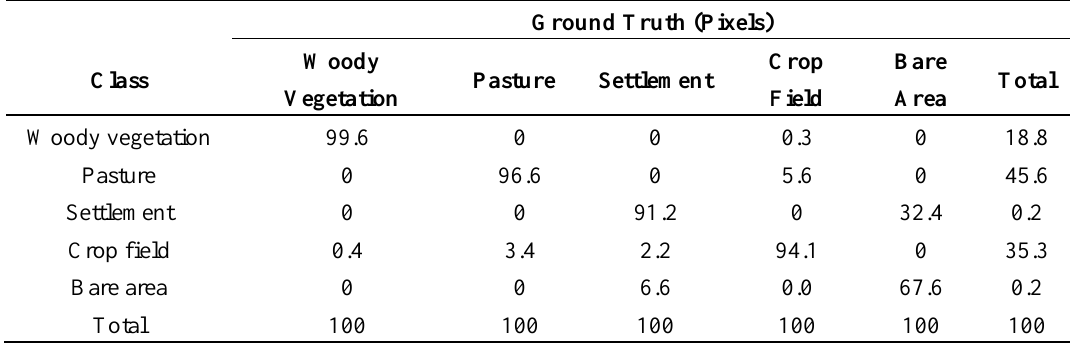
Table A2. Confusion matrix—1979 image classification after pansharpening. Overall Accuracy = 96.17%, Kappa Coefficient =